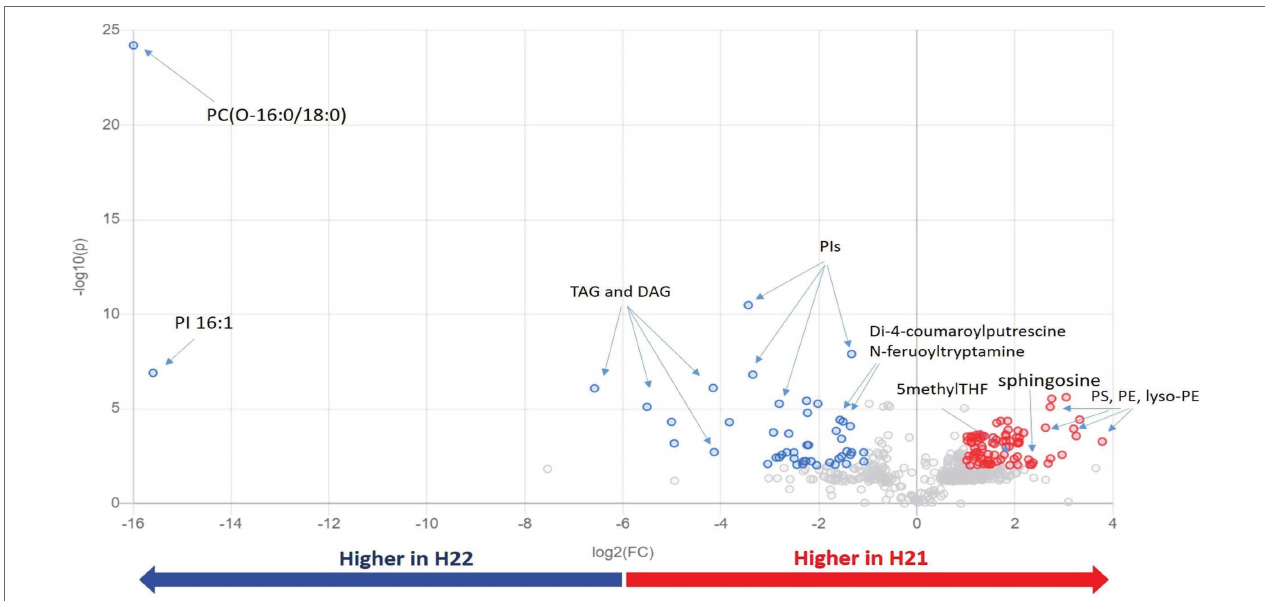
FIGURE 2 | Important features selected by volcano plot analysis, based on the thresholds of fold change [ x -axis; log 2 (FC) = 2] and t -test [ y -axis; − log 10 ( p ) = 0.01]. Data were adjusted according to the false discovery rate (FDR). Colored circles represent features above the thresholds; features accumulated to higher levels in H21 are indicated in red, whereas those accumulated to higher levels in H22 are indicated in blue. The further its position from the (0,0) point, the more significant the feature. PC, glycerophosphocholine; PE, glycerophosphoethanolamine; PG, glycerophosphoglycerol; PI, glycerophosphoinositol; TAGs, triacylglycerols; DAGs, diacylglycerols; and THF, tetrahydrofolate.